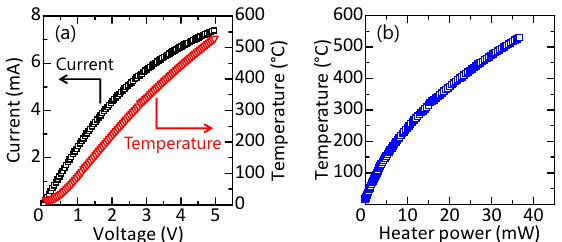
Figure 5. ( a ) I − V characteristics of the heater. The corresponding temperature calculated from the heater resistance is also plotted; ( b ) The temperature of the heater plotted against the power